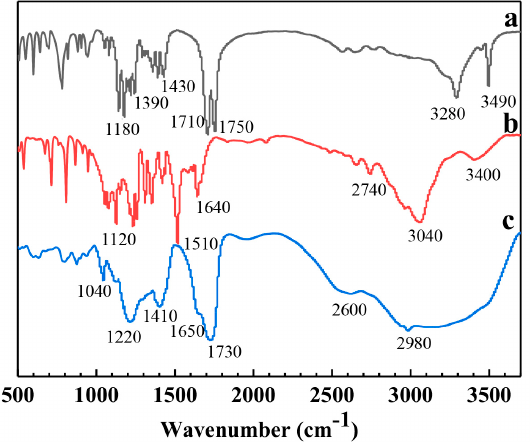
Figure 2. FTIR spectra of ( a ) CA, ( b ) L-Glutamic, and ( c ) N-GQDs.